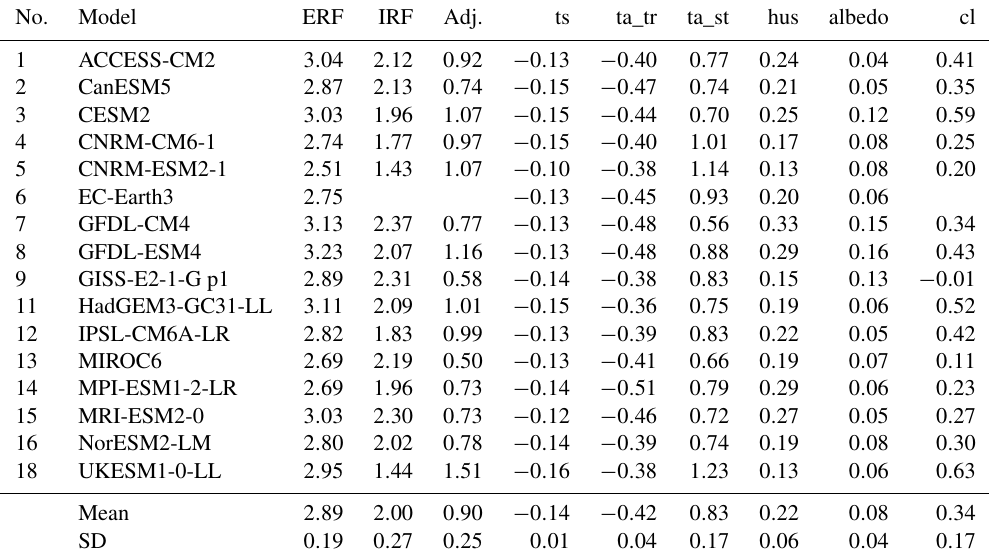
Table 4. As for Table 3 but for 1850–2014 well-mixed greenhouse gas